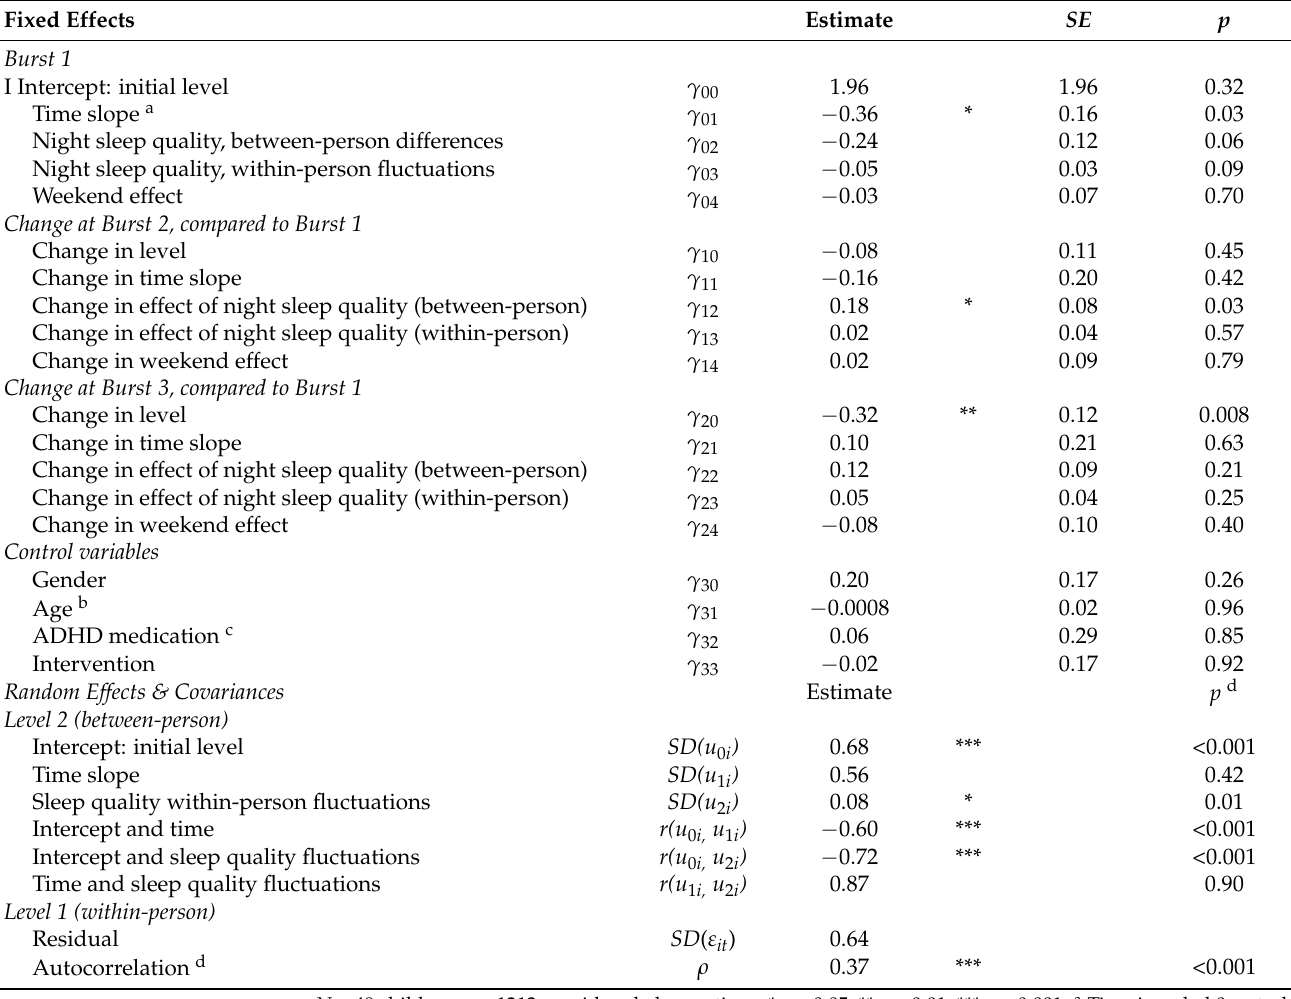
Table A3. Multilevel model to test the between- and within-person association between children’s night sleep quality and ADHD symptom levels the following day.